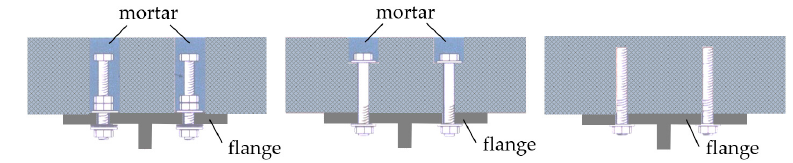
Figure 1. Variations of headed shear stud connectors.